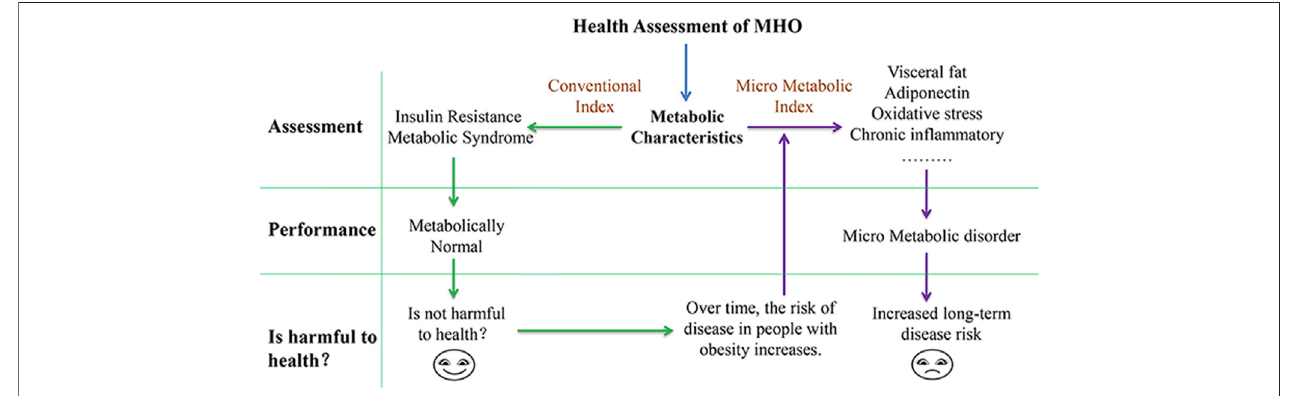
FIGURE 1 | Health evaluation and hazard reason of